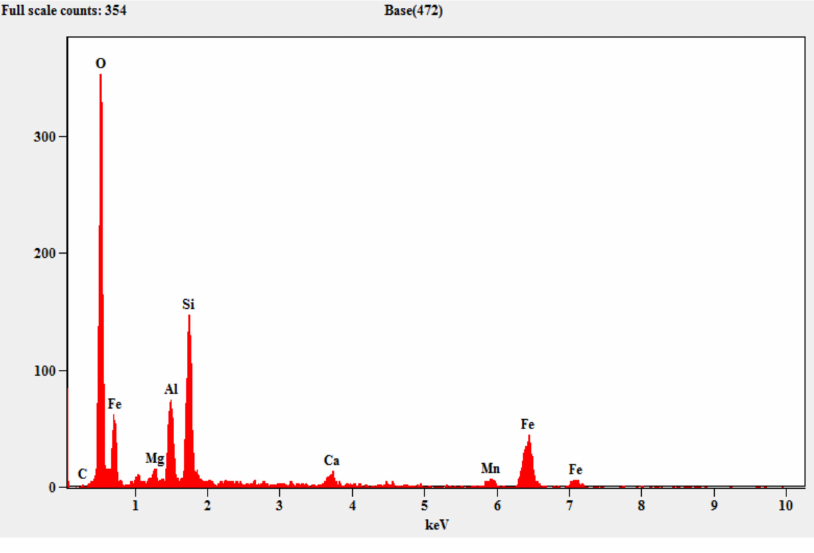
Figure 14. EDAX for steel